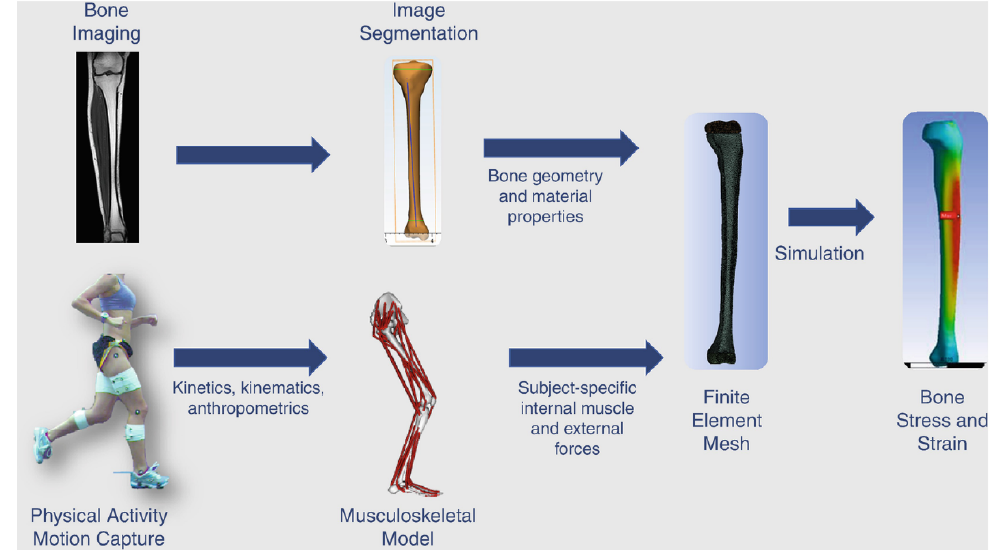
Fig. 4 Schematic diagram of the momentary load of the human lower limbs landing.